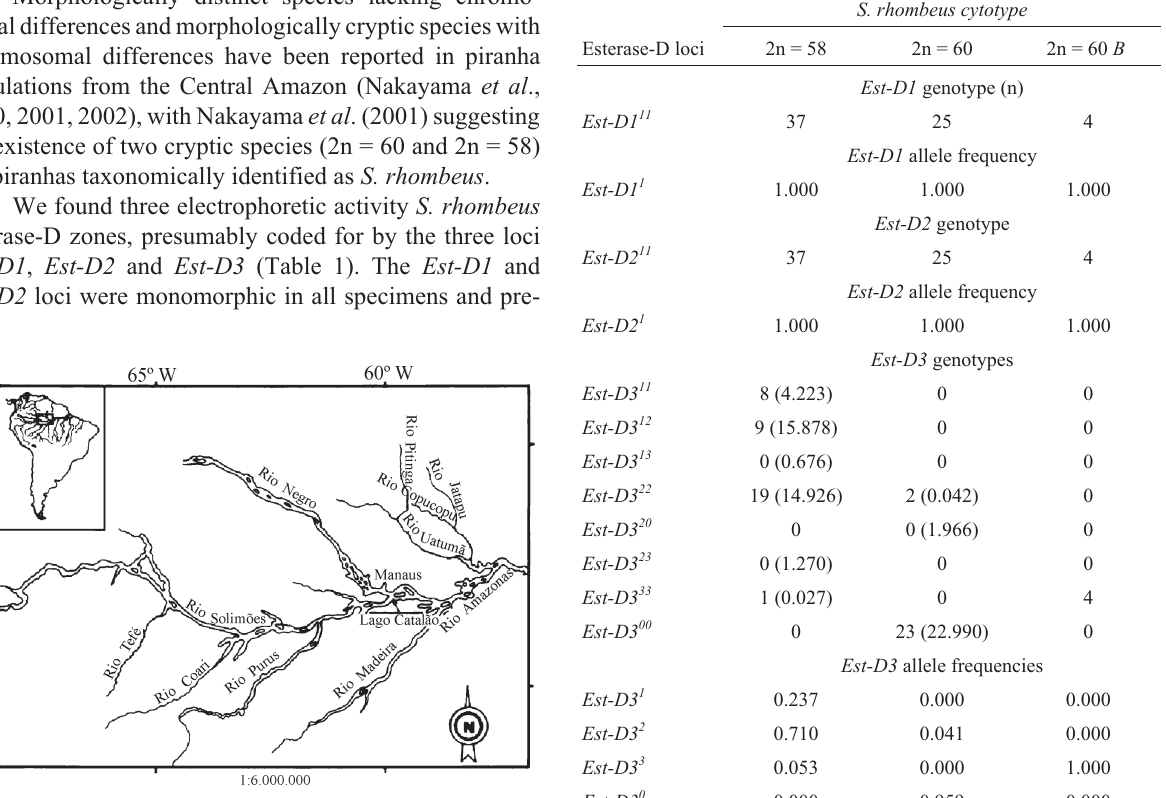
Table 1 - Cytotype and allele frequency distributions for esterase-D loci Est-D1 , Est-D2 and Est-D3 for the 2n = 58 (n = 37 specimens), 2n = 60 (n = 25) and 2n = 60 B (n = 4) Serrasalmus rhombeus karyotypes from Lake Catalão in the Brazilian Central Amazon. The expected number of some Est-D3 polymorphic locus genotypes are shown in parentheses beside observed